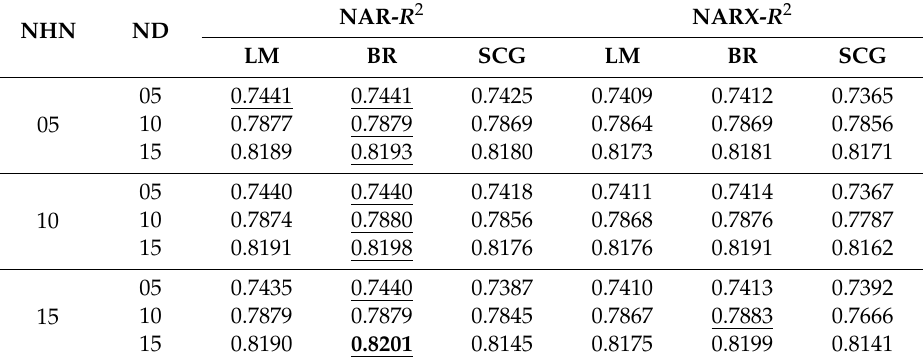
Table 7. Benchmark evaluation with nonlinear autoregressive methods based on R 2 . NHN: number of hidden neurons; ND: number of regressors; LM: Levenberg–Marquardt; BR: Bayesian Regularization; SCG: Scaled Conjugate Gradient; NAR: Nonlinear Autoregressive; NARX: Nonlinear Autoregressive with Exogenous Input.